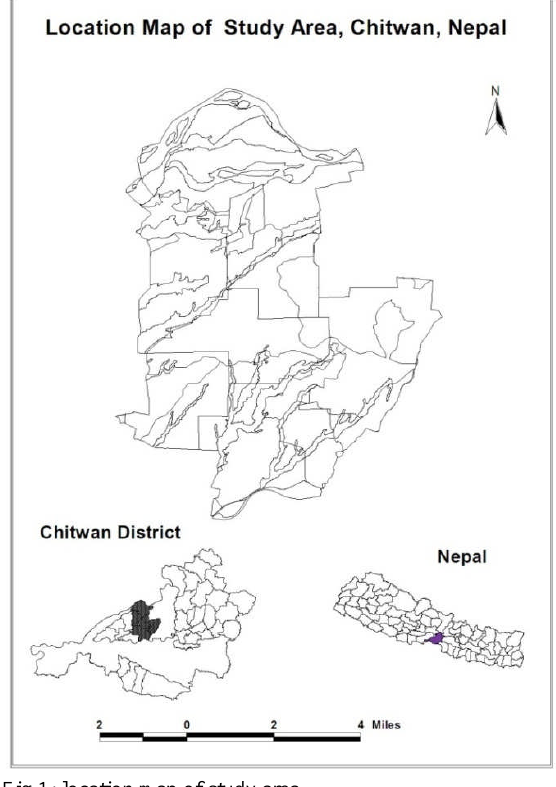
Fig 1: location map of study area